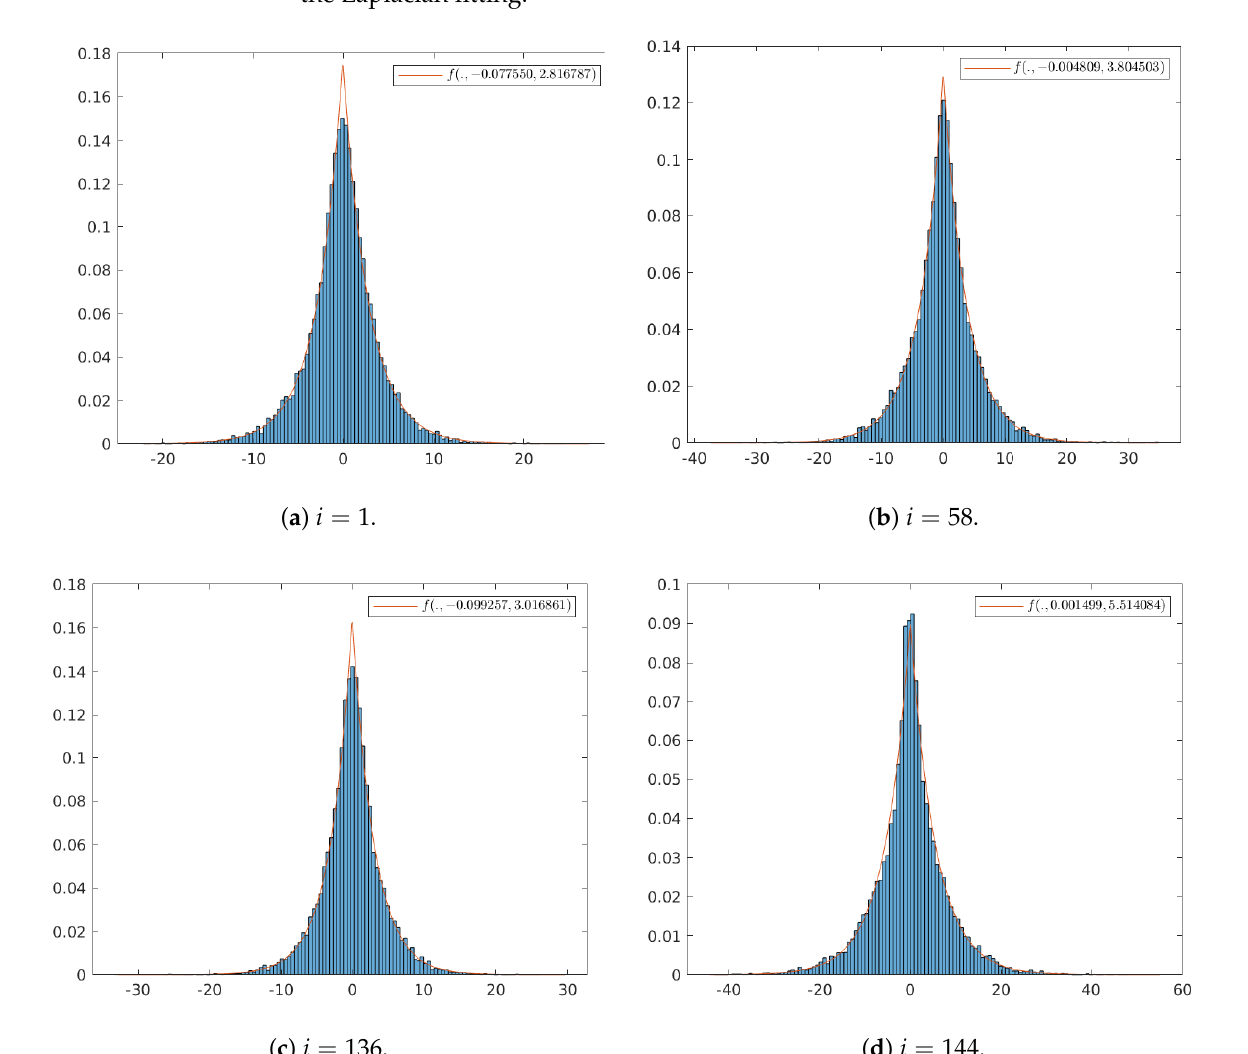
tograms (derived from 16 observations) of some feature maps (each of size 32 × 32) and the Laplacian fitting.